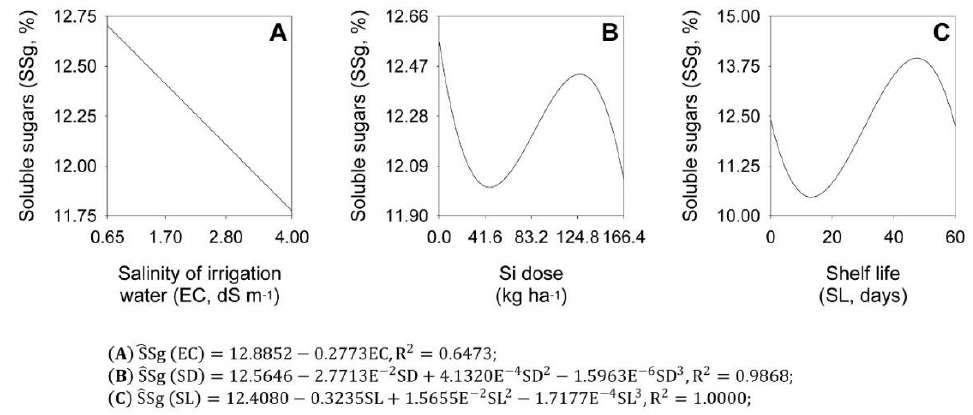
Figure 3. Effect of salinity levels (EC) ( A ), silicon doses (SD) ( B ), and shelf life (SL) ( C ) on total soluble sugars (SSg) in ‘ Rio das Antas ’ onion bulbs.